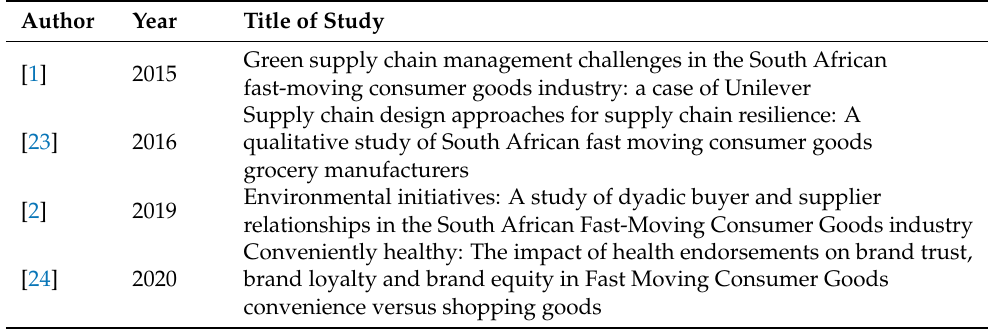
Table 1. Summary of literature in the fast-moving consumer goods